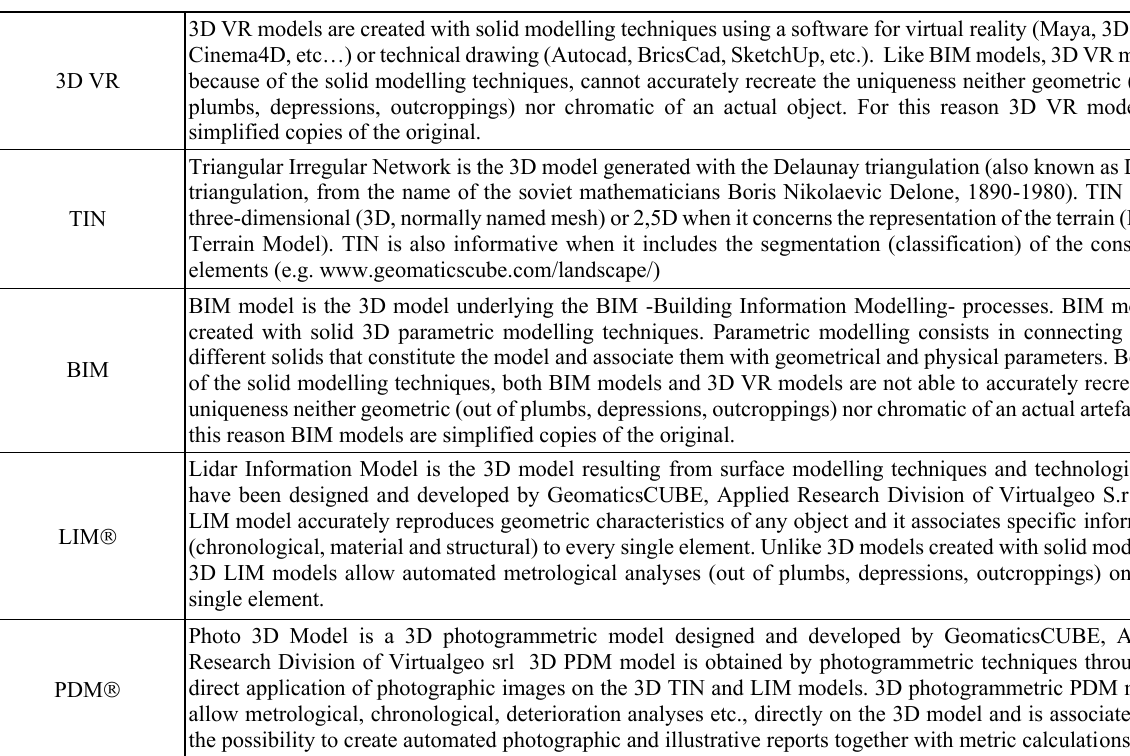
Table 2. Types and characteristics of the 3D